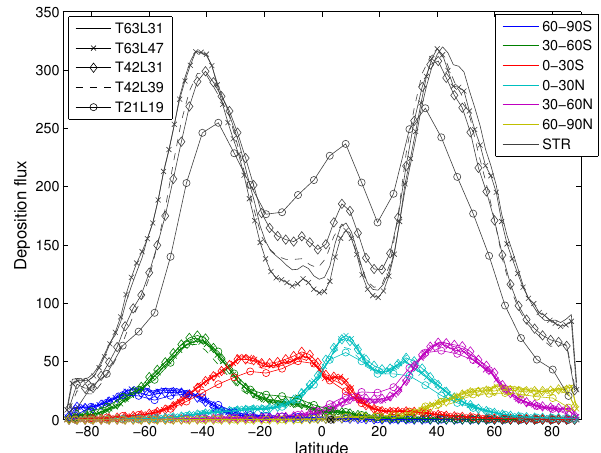
Fig. 10. Zonal mean deposition flux of 10 Be atoms (m − 2 s − 1 ) with different resolutions. Fluxes of 10 Be produced in different atmo- spheric compartments are shown separately (stratosphere (STR) and the 30-degree latitude bands in the troposphere).